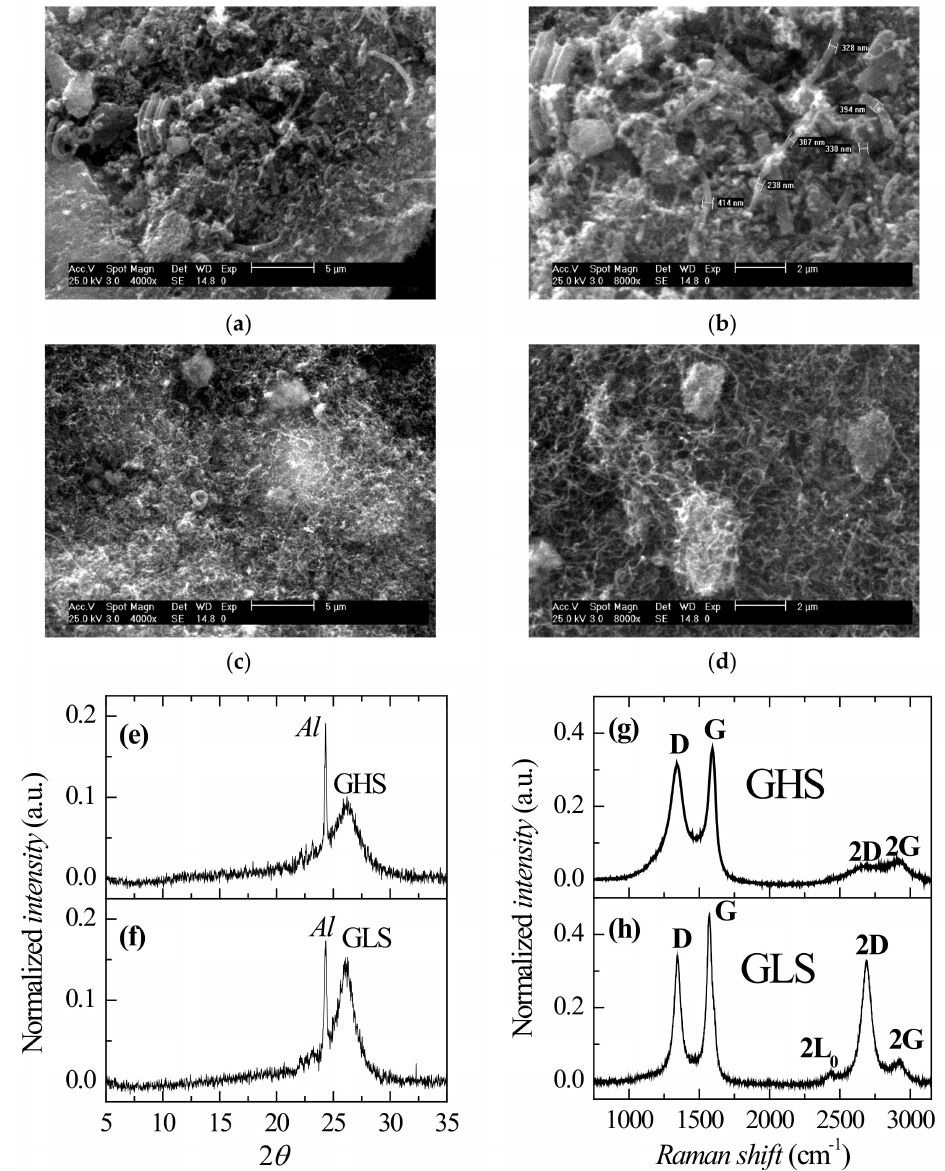
Figure 1. SEM micrographs of graphene nanofibers at two magnifications: GHS ( a , b ) and GLS ( c , d ). X-ray diffractograms of GHS ( e ) and GLS ( f ) nanofibers. These nanofibers were wrapped in alu- minum foil (see Al diffraction peak at a value of 2 θ of 24.3 ◦ ). Raman spectra of GHS ( g ) and GLS ( h ) graphene